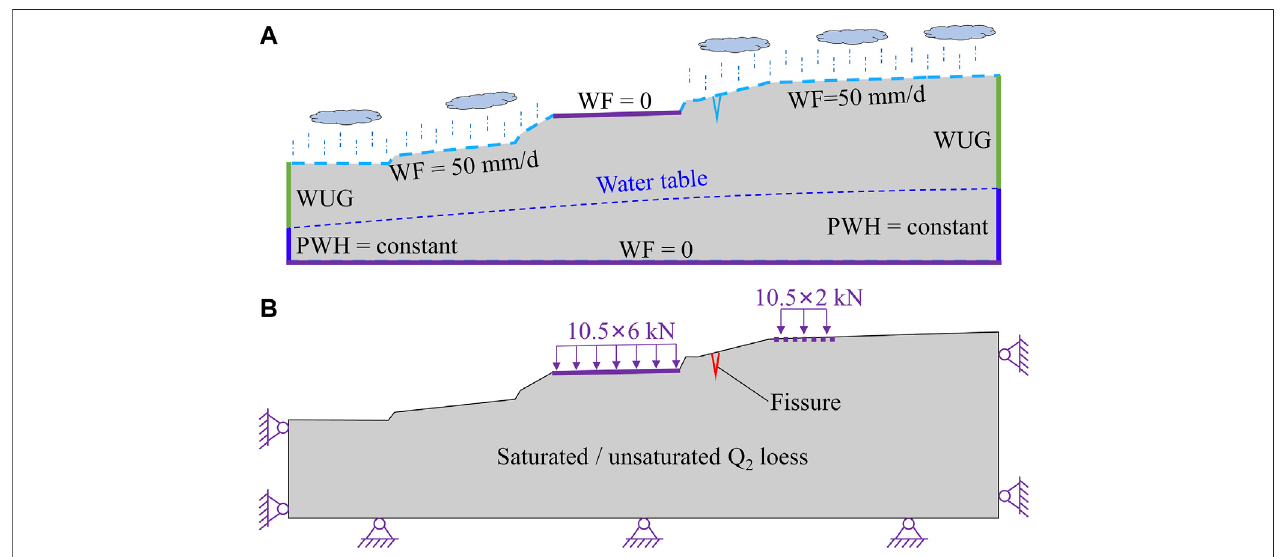
FIGURE 7 | Boundary conditions for seepage calculation (A) and mechanical calculation (B) .